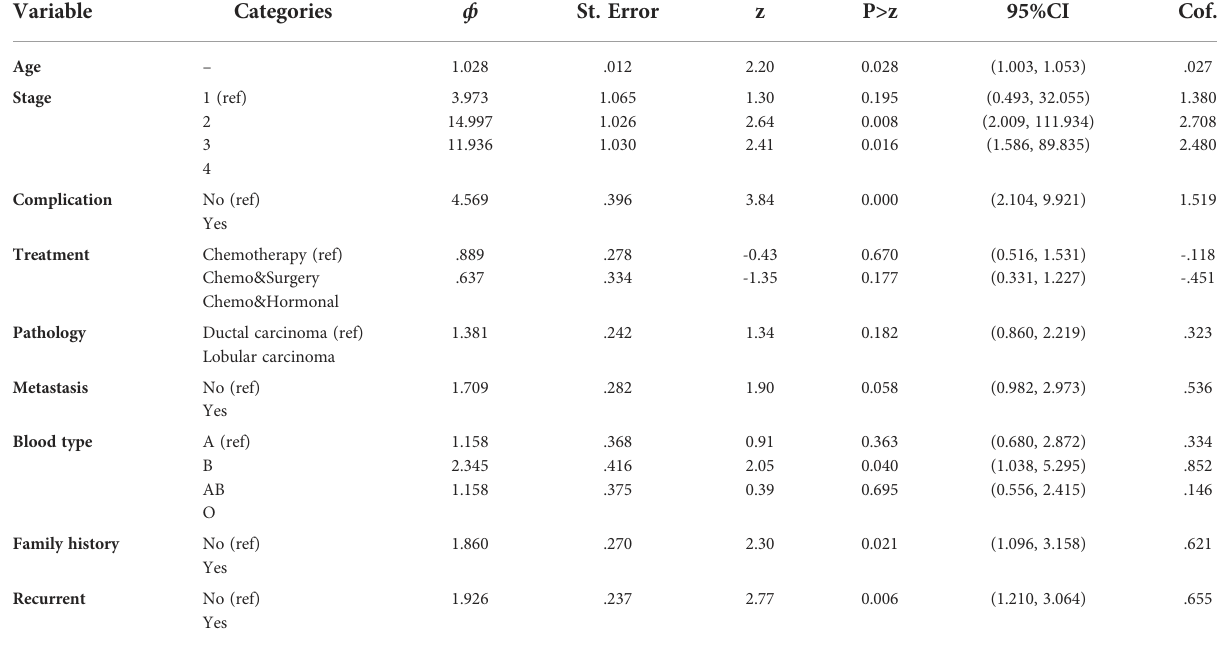
TABLE 2 Multivariable cox proportional hazards regression model